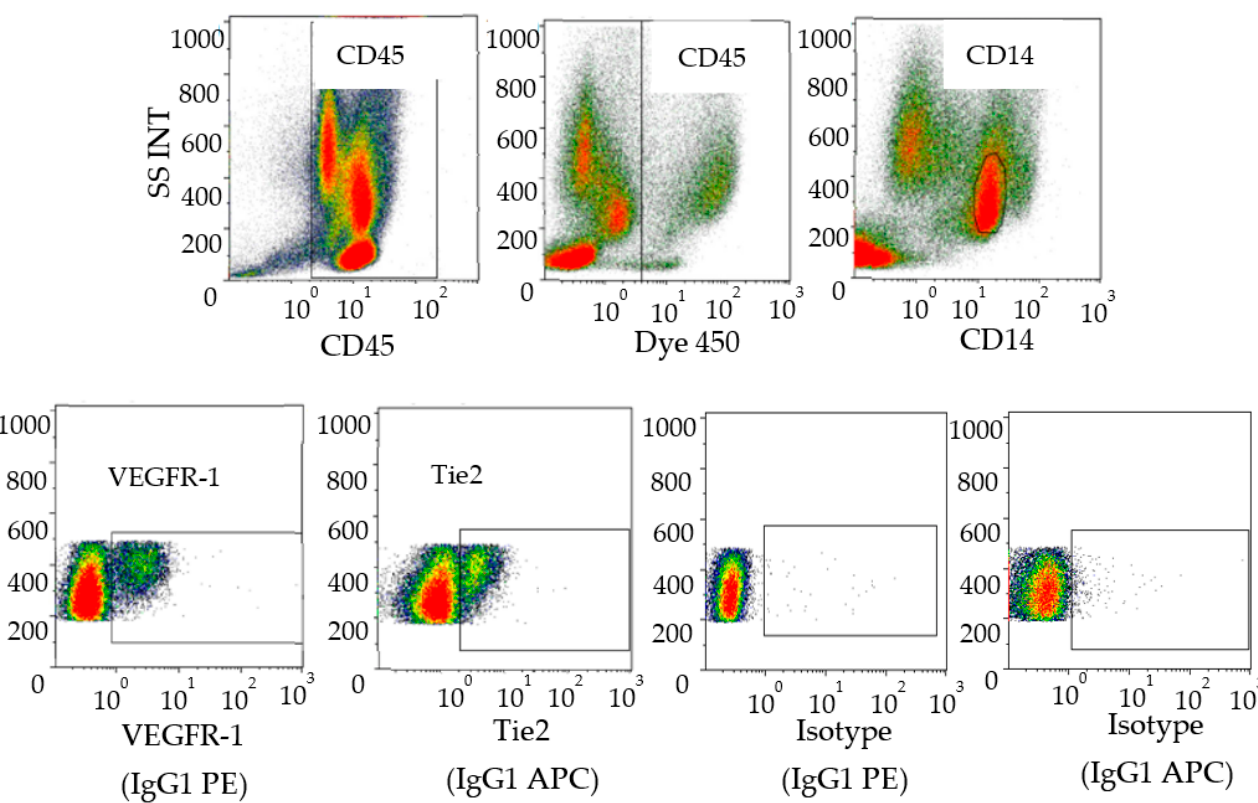
Figure 2 : Characterization of human pro-angiogenic monocytes in blood. Peripheral blood mononuclear cells were stained with anti-CD45, anti-CD14, anti-VEGFR-1 and anti-Tie 2. The data analysis was performed as follows: Selection of CD45 + cells then live cells followed by gating on CD14 + cells and expression of VEGFR-1 or Tie-2 + cells on the monocyte population. Isotype controls corresponding to anti-VEGR-1 (IgG1 PE) and anti-Tie2 (IgG1 APC) were shown (bottom right). Data acquisition was performed with a Navios (Beckman Coulter) and analyses were performed with Kaluza software (Beckman Coulter, Villepinte 95942 Roissy CDG, France).